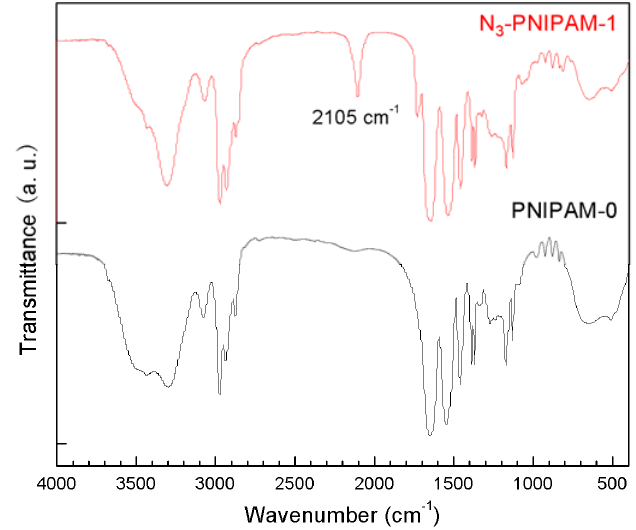
-PNIPAM-1 ( A ) and PNIPAM-0 ( B ) 3